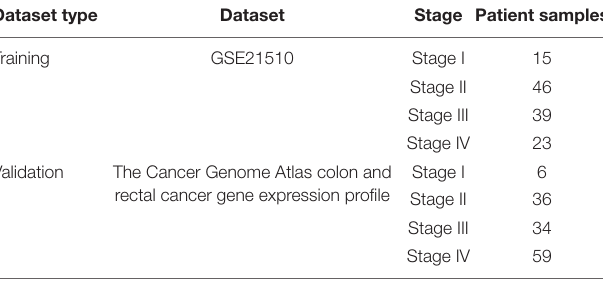
TABLE 1 | Samples for TNM staging system associated with colon and rectal cancer.